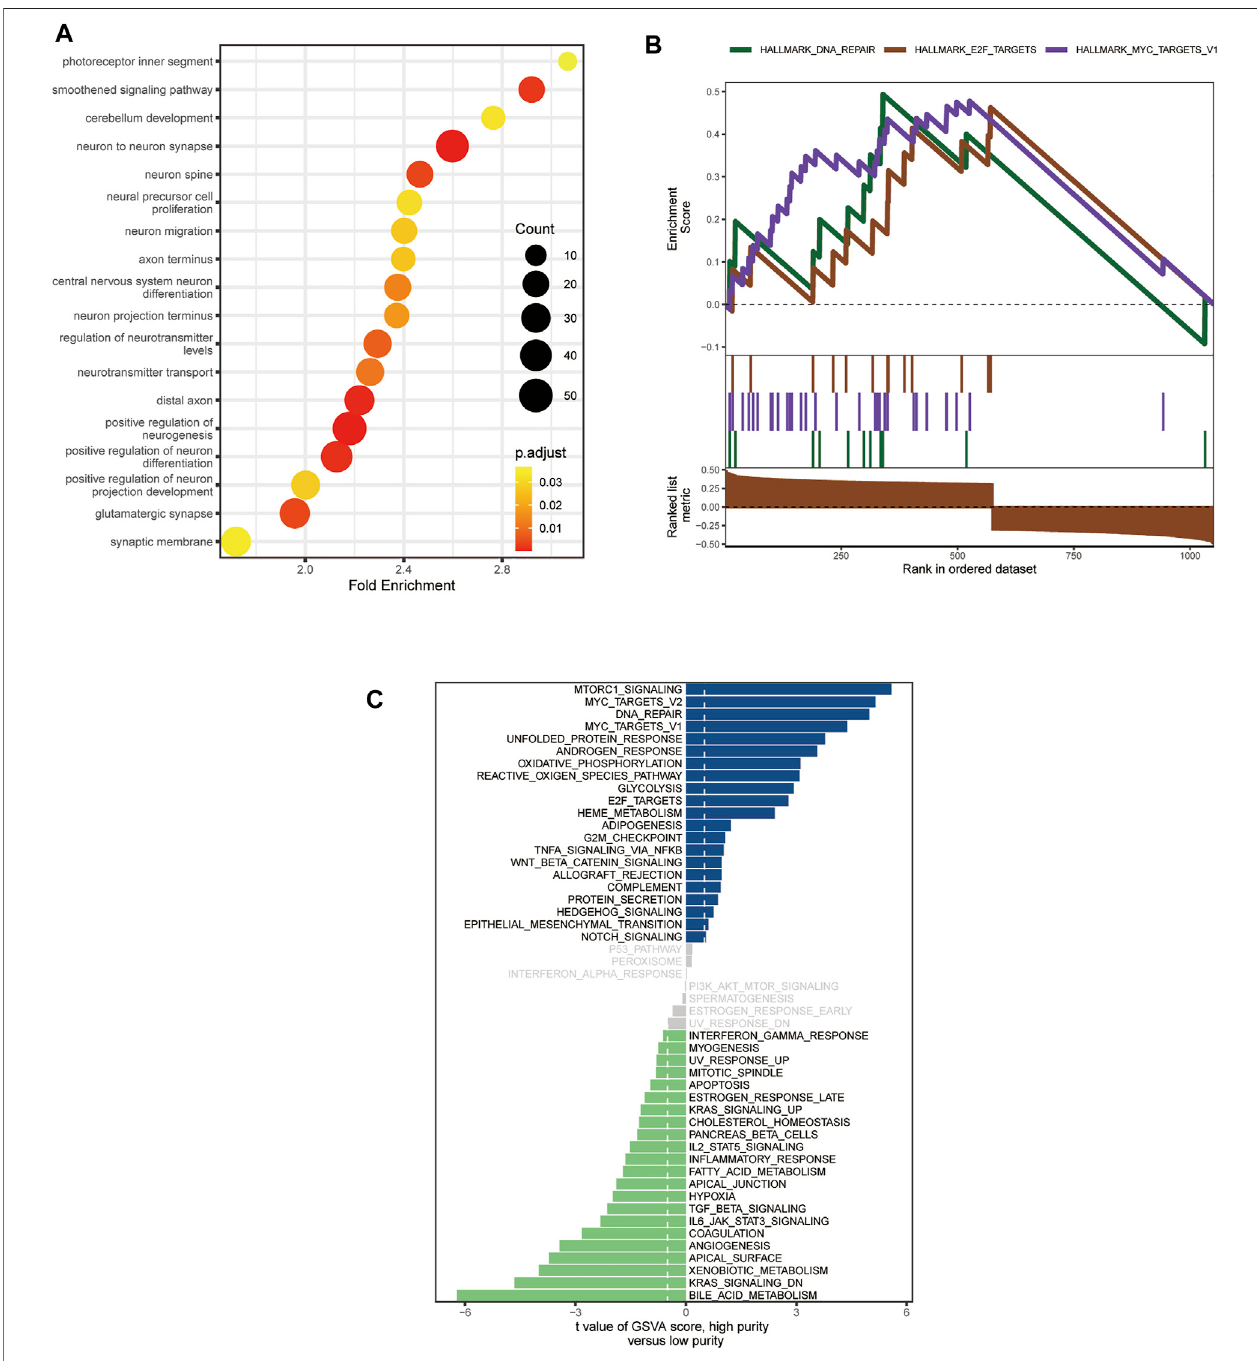
FIGURE 7 | Biological functions related to the purity of medulloblastoma (MB) in the GSE85218 dataset. (A) Biological pathways related to the MB purity as revealed by Gene Ontology (GO) analysis; (B) biological pathways related to Mb purity as revealed by gene set enrichment analysis (GSEA); (C) biological pathways related to MB purity as revealed by gene set variation analysis